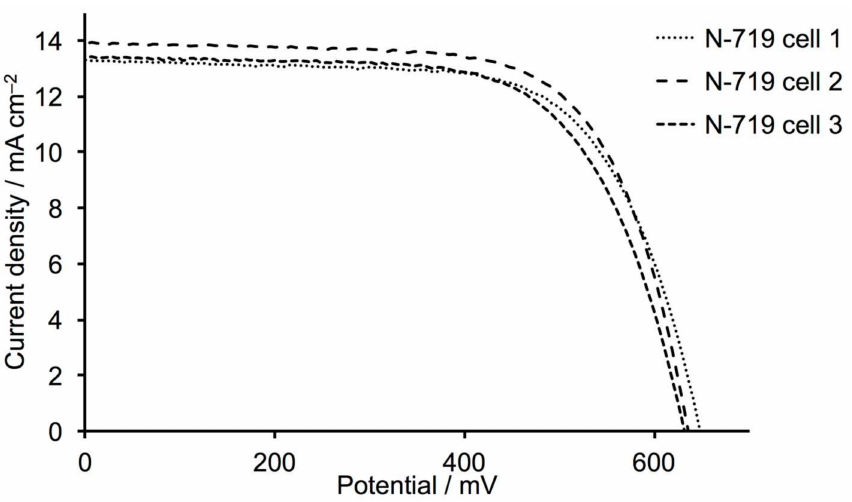
Figure 6. J – V curves for three N719 reference cells (DSSCs were fully masked). Table 2. Performance parameters (under 1 sun illumination) of duplicate, masked DSSCs (mask aperture calibrated and ca. 0.06 cm 2 ) with [Cu( 5 )(L ancillary )] + (L ancillary = 1 , 2 , 3, or 4 ) on the day of sealing the cells, and after seven days. The data is compared to a DSSC containing N719 and relative η values are with respect to N719 set at 100% a